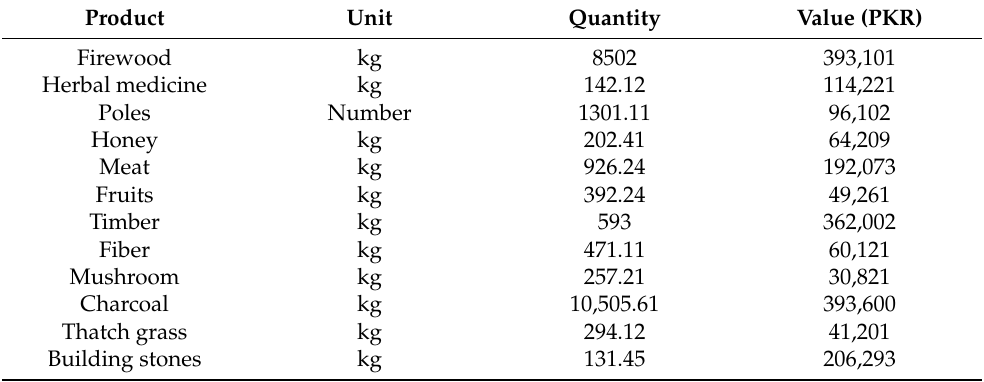
Table 5. Quantities and monetary value of forest products extracted by households monthly (2019).